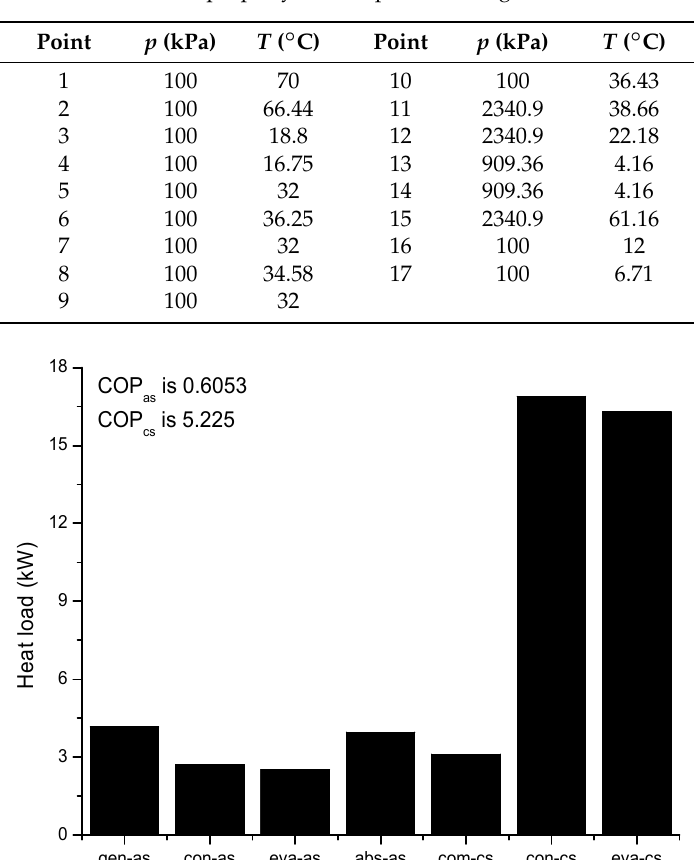
Table 4. State property of each point in design condition.